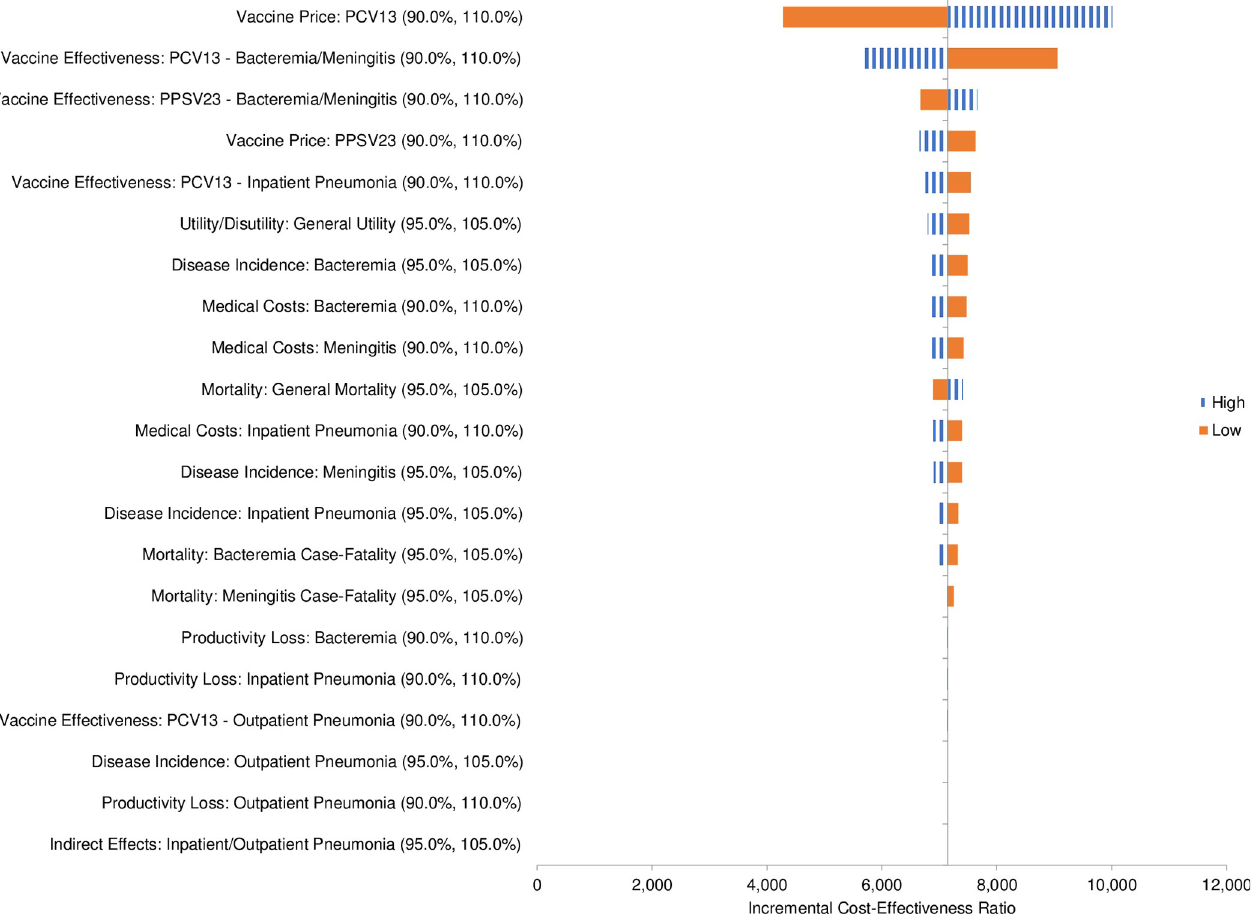
Fig 4. One-way deterministic sensitivity analyses for the public health care sector HIV-infected model. Incremental cost-effectiveness ratio is indicated in 2015 South African rand/QALY.